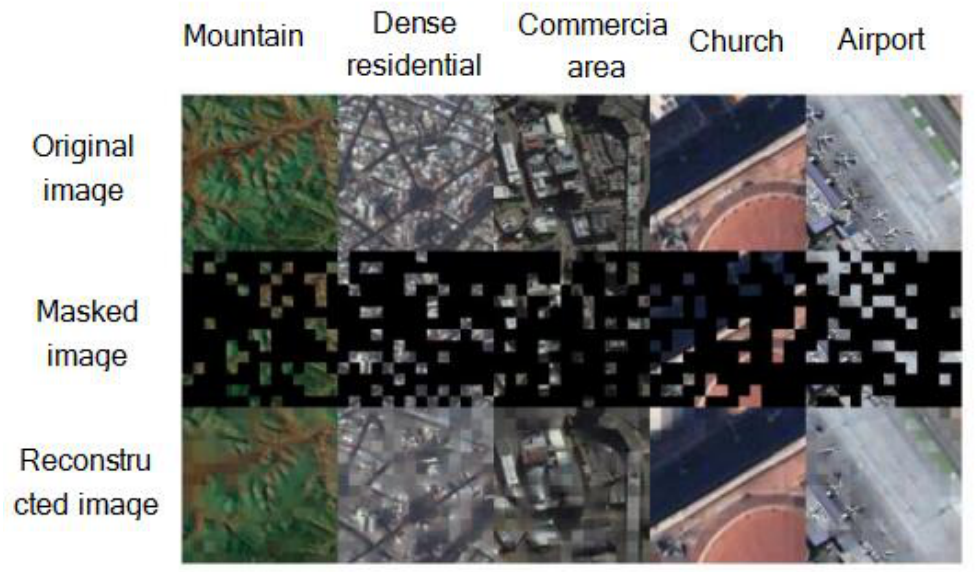
Figure 4. Pixel reconstruction results of self-supervised learning pre-trained model on AID data set. (2) Result on NWPU dataset: Table 2 shows the overall accuracy comparison of